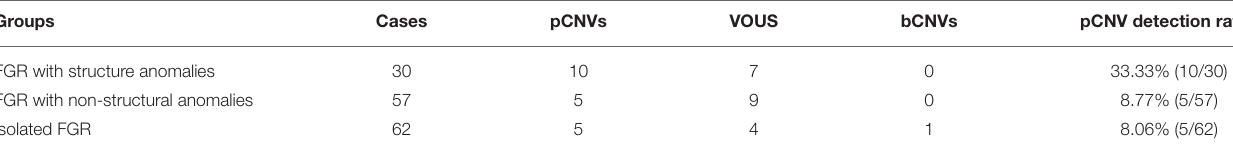
TABLE 3 | Detection rates of CNVs among FGR groups with different ultrasound anomalies.